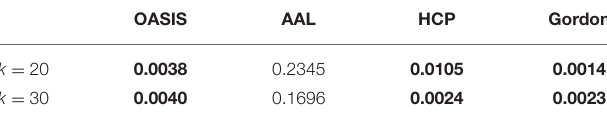
TABLE 4 | P -values of Kruskal-Wallis testing for k -core differences among the NC, EMCI, LMCI, and AD groups. OASIS